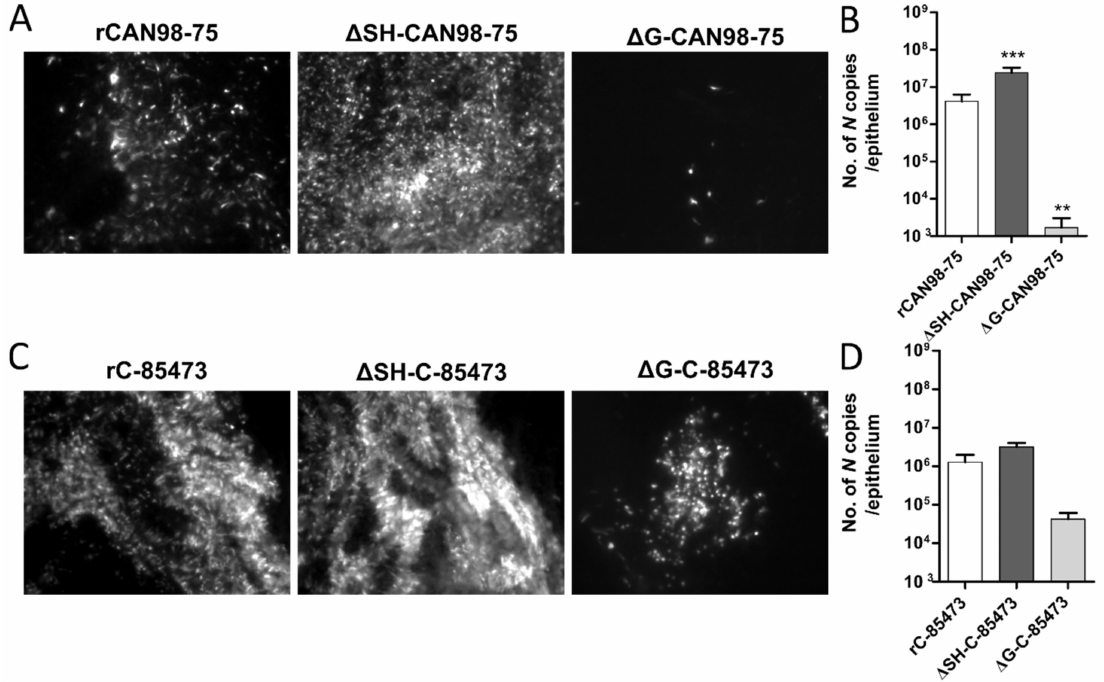
Figure 3. Recombinant HMPV viruses di ff ered in infectivity and viral growth in reconstituted human airway epithelium (HAE). MucilAir ™ epithelium from healthy donors were infected with the di ff erent rHMPV strains at a MOI of 0.1. At 5 dpi, the viral spread in infected ciliated cells was monitored by fluorescence microscopy (images at 10 × magnification) and the quantity of viral genome was measured by specific RT-qPCR against the N viral gene from epithelium lysates, respectively ( A ) and ( B ) for rCAN98-75-derived viruses or ( C ) and ( D ) for rC-85473-derived viruses. Genome quantifications are shown as means ± SD and represent experimental triplicates. ** p < 0.01, *** p < 0.001 when comparing each ∆ SH / ∆ G virus to its WT counterpart using repeated measures two-way